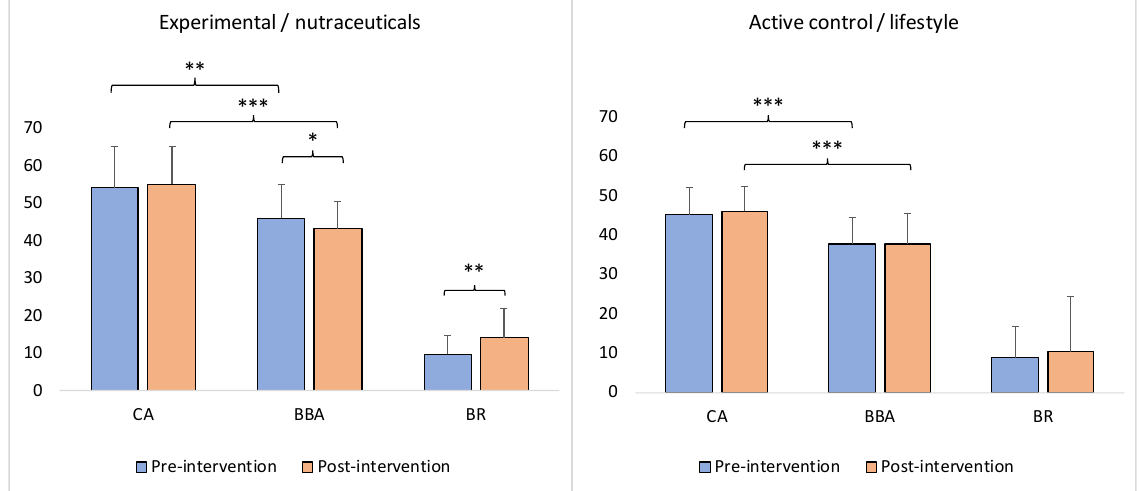
Figure 2. Intervention-induced changes in BBA and BR in the experimental (nutraceutical com- pounds) and active control (lifestyle) groups. The y -axis represents years for the BBA and CA and the percentage for the BR. CA: chronological age; BBA: biological brain age; BR: brain resources. The asterisk(s) denotes p < 0.05 (*), p < 0.01 (**), and p < 0.001 (***). The bars represent the means with standard errors.